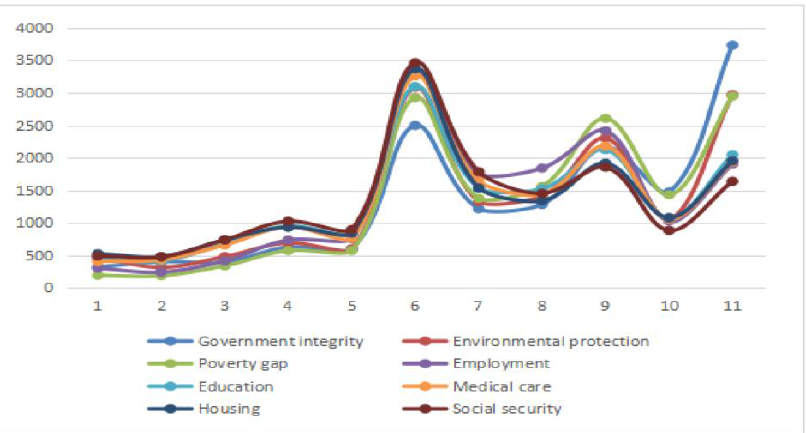
Figure 2. Diagram of the trends in rural residents’ satisfaction with the social environment.